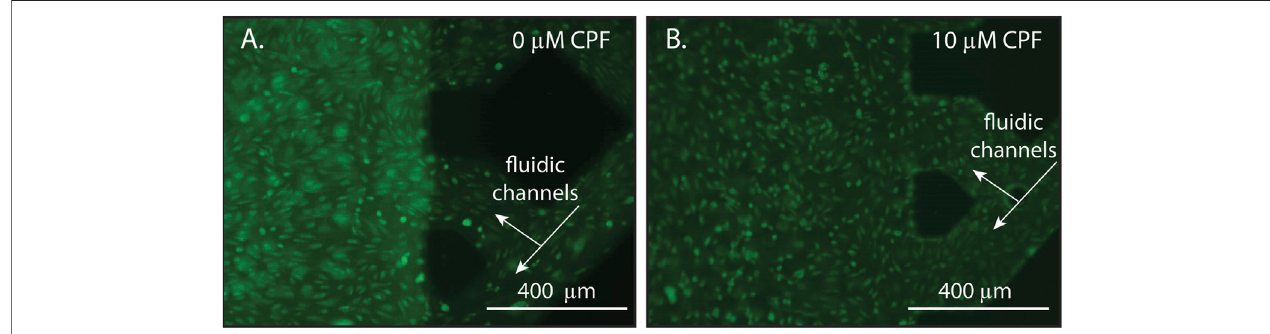
FIGURE 3 | Representative microscopy images of endothelial cells within an NVU following 24 h of continuous exposure with either (A) DMSO (vehicle control, panel A ) or (B) CPF (10 μ M, panel B ). The lattice seen at the right of each image is the micro fl uidic channels of the vascular side of the NVU. (A) A control NVU showing evenlydispersedcellswithtypical morphology,indicatingahealthyBBB. (B) ACPF-treated NVUshowingpunctate cellmorphology (contracted cells),indicating cellular stress in response to the CPF treatment. For these experiments, the NVUs were perfused with neurobasal media on the neuronal side and EBM2 media on the vascular side either with or without CPF. All cultures were maintained at 37 ° C and 5% CO 2